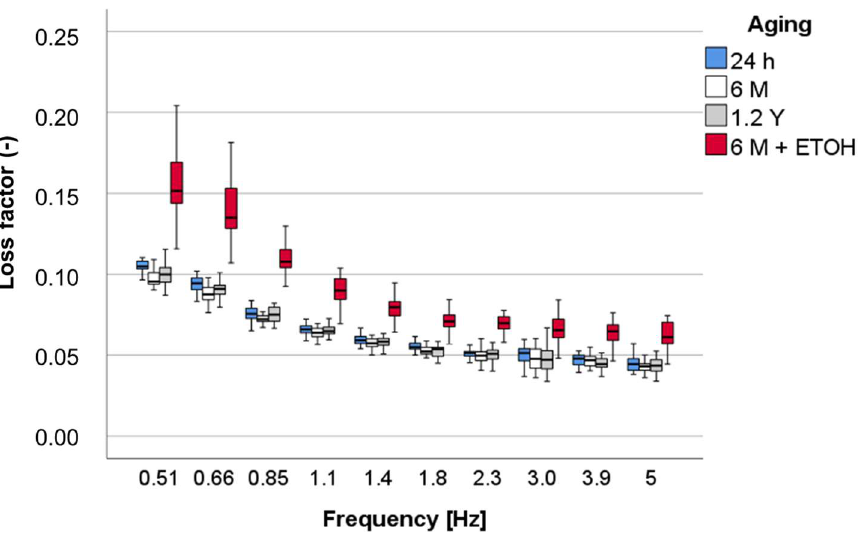
Figure 8. Loss factor (tan δ ) as a function of frequency and aging method, exemplified for the material OC.